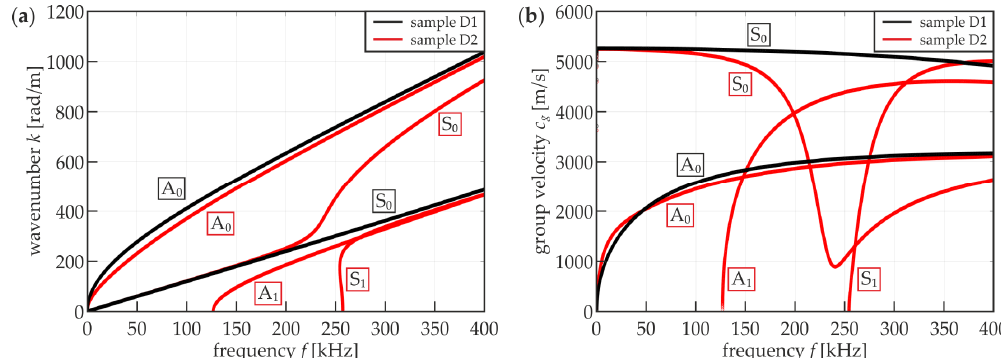
Figure 7. Theoretical dispersion curves for a steel plate (D1, black curves)–single layer medium ( d s = 3 mm, E s = 195.2 GPa, vs. = 0.3, ρ s = 7741.7 kg/m 3 ) and adhesive joint (D2, red curves)–three-layer medium consisting of two steel plates (parameters same as above) and adhesive film ( d a = 0.2 mm, E a = 5 GPa, v a = 0.35, ρ a = 1330 kg/m 3 ): ( a ) wavenumber–frequency relations; ( b ) group velocity–frequency relations.